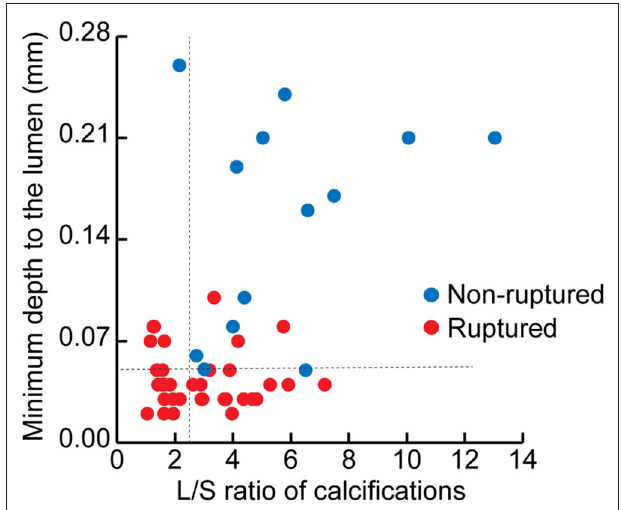
FIGURE 3 | The distribution of calcifications in ruptured and non-ruptured plaques according to the minimal depth from the calcification to the lumen and the long axis/short axis (L/S) ratio of each